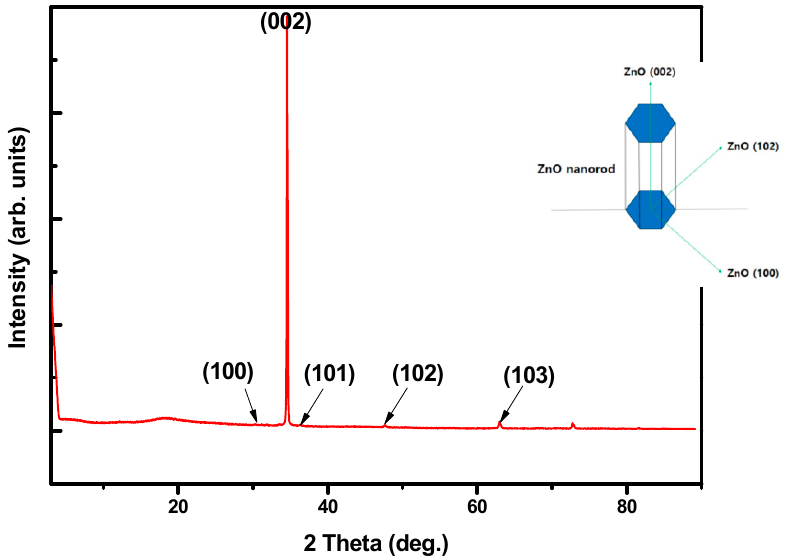
Figure 6. XRD pattern of the ZnO nanorod with the highest aspect ratio of 11:1.